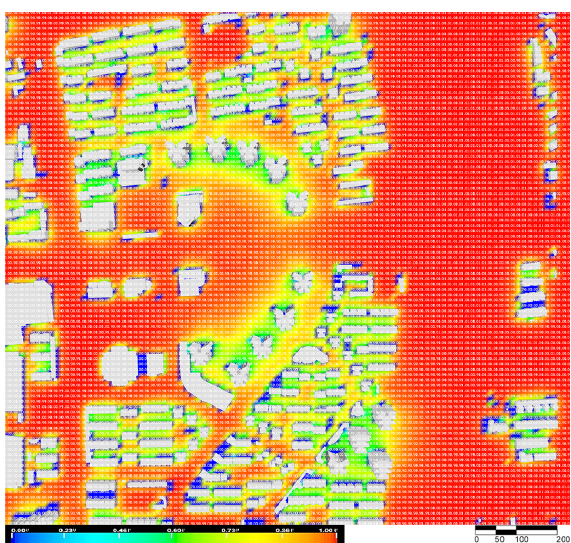
Figure 9. This figure shows Xinjiekou, an inner city Nan- jing, China, SVF calculated at 10m